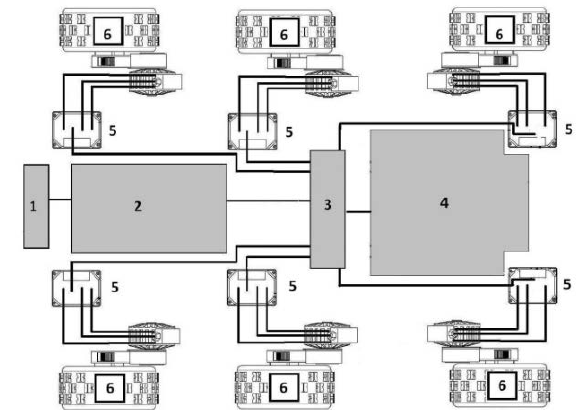
Fig. 3. Schematic connections of hybrid power propulsion: 1) steering system, 2) power generator, 3) junction box, 4) battery, 5) inverters, 6)